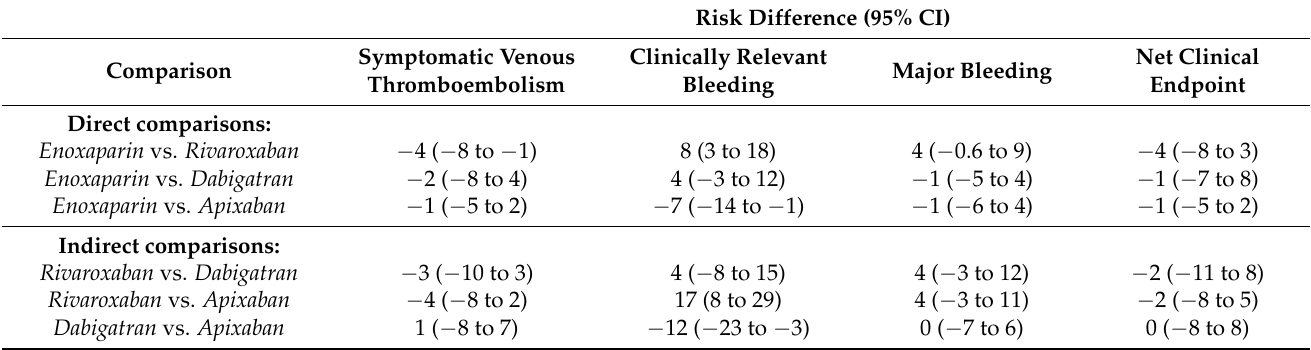
Table 3. Direct and indirect comparisons: absolute difference in events per 1000 patients treated